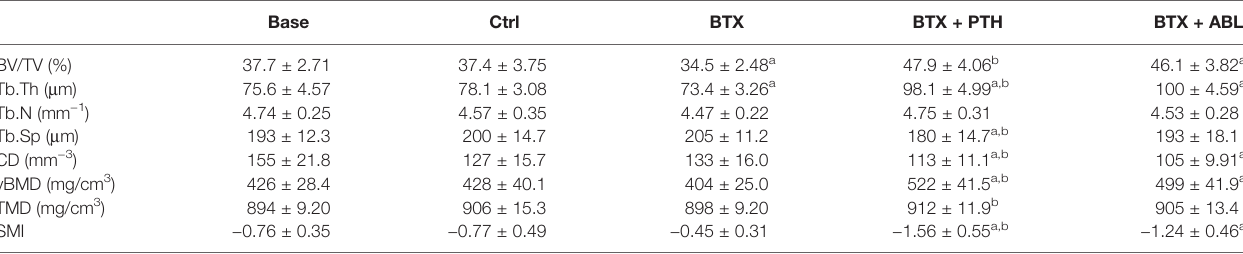
TABLE 4 | Microstructural properties of L5 from rats with the right hindlimb immobilized with BTX and treated with PTH or ABL.